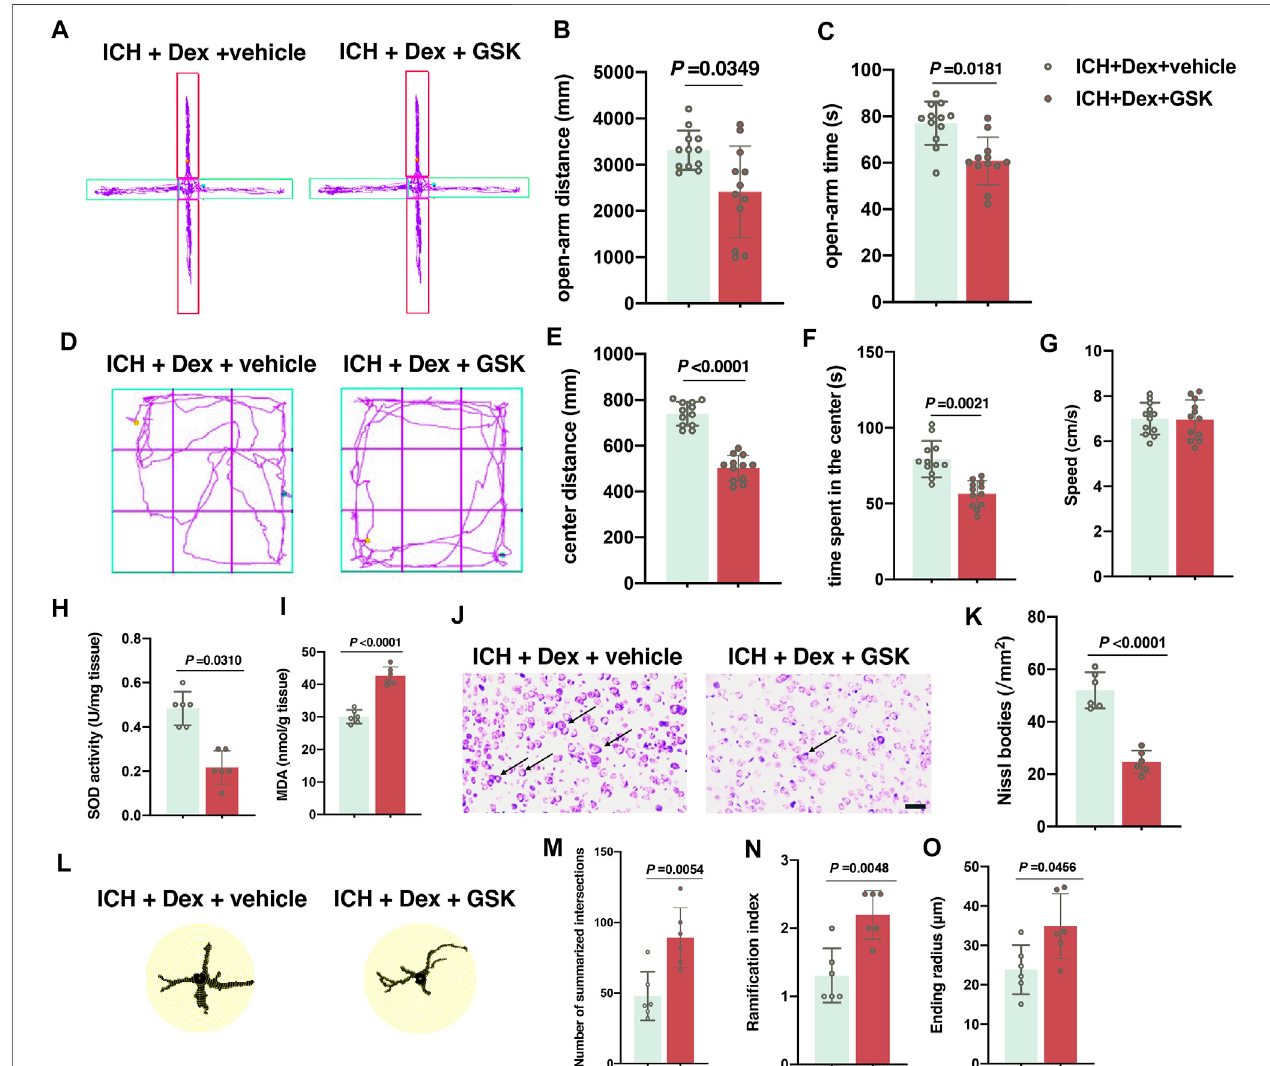
FIGURE 5 | GSK1016790A reversed the neuroprotective effects induced by dexmedetomidine-post-ICH. (A) Computer printouts of shift trajectories in the elevated plus-maze caused by the indicated stimuli 30 d post-ICH. (B,C) Distance and time in the open-arm during the elevated plus-maze results caused by the indicated stimuli 30 d post-ICH. (D) Computer printouts of shift trajectories in the open- fi eld caused by the indicated stimuli 30 d post-ICH. (E – G) Distance and time in the central zone, and average speed during the open- fi eld test results caused by the indicated stimuli 30 d post-ICH. (H,I) Changes in the total SOD and MDA contentsaroundthehematoma inthecorpusstriatum causedbytheindicatedstimuli. (J,K) RepresentativephotomicrographsofNisslstainingand Nisslbodiesaround the hematoma in the corpus striatum caused by the indicated stimuli. Arrows indicate Nissl bodies. (L) Representative detailed Sholl analysis of individual reactive astrocytesaroundthehematomainthecorpusstriatumcausedbytheindicatedstimuli. (M – O) Changesinthesumofintersects,rami fi cationindex,andendingradiusin thecorpusstriatumcausedbytheindicatedstimuli. (P) RepresentativephotomicrographsofGFAPandC3complementplusDAPIstaining(GFAP,red;C3complement, green; DAPI, blue). 400× magni fi cation, scale bar = 50 μ m. (Q) Representative photomicrographs of GFAP and S100 β plus DAPI staining (GFAP, red; S100 β , green; DAPI,blue).200×magni fi cation,scalebar=50 μ m. (R) ThepercentageofGFAPcombinedwithC3complement-positivecells(A1-type)causedbytheindicatedstimuli. (S) Thepercentage ofGFAPcombinedwithS100 β -positivecells(A2-type)causedbytheindicatedstimuli.Dataarepresentedasthemean±SD( n =12or6).ICH, Dex, and GSK are described above.